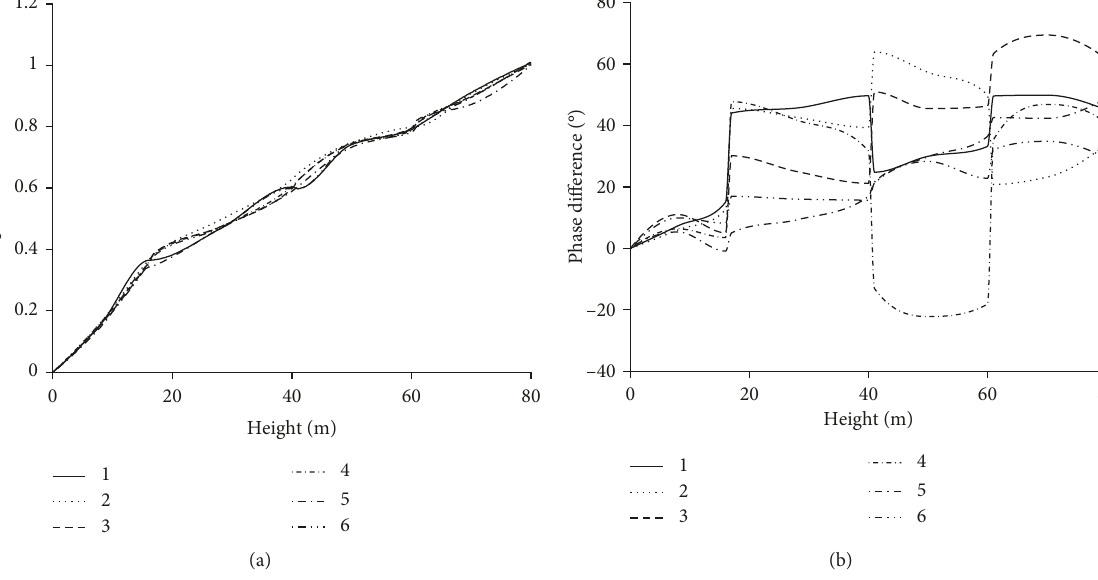
Figure 9: Vibration modes and phase differences of the No. 6 wind turbine tower. (a) The first-order vibration mode under six working conditions. (b) The first-order phase difference under six working